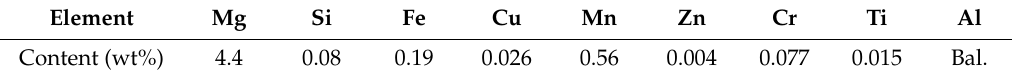
Table 1. Elemental (wt%) composition of commercial